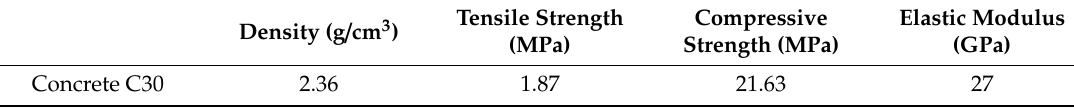
Figure 4. Concrete-cube specimens. Table 1. Mechanical parameters of specimens.